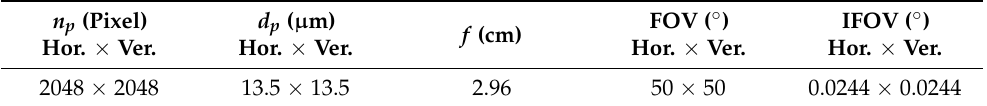
Table 1. Technical specifications of the chaser-fixed camera and its optics, assuming the Teledyne CCD42-40 as